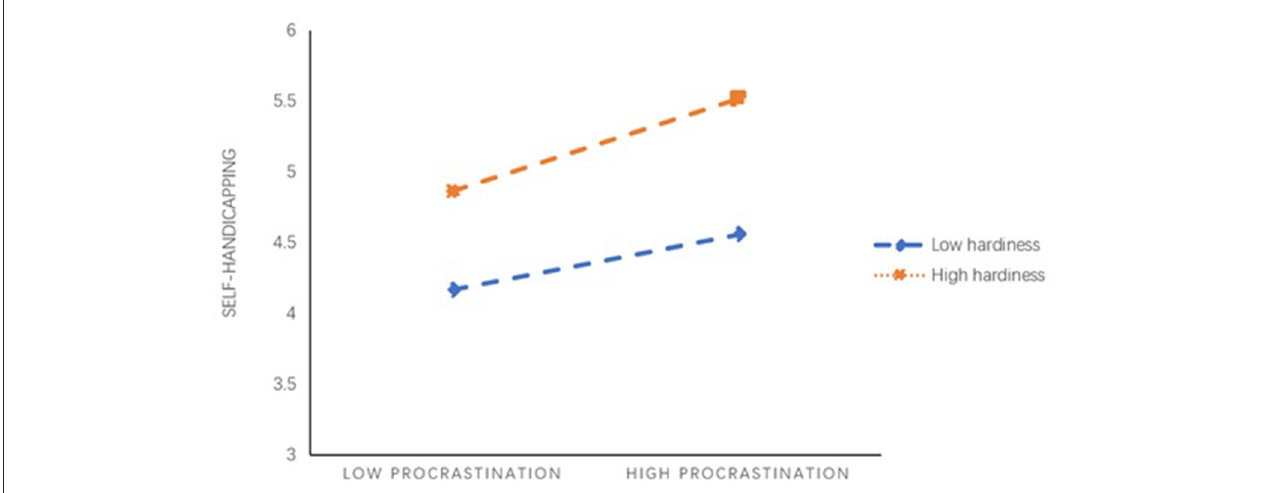
FIGURE 4 | Hardiness moderates the relationship between procrastination and self-handicapping.